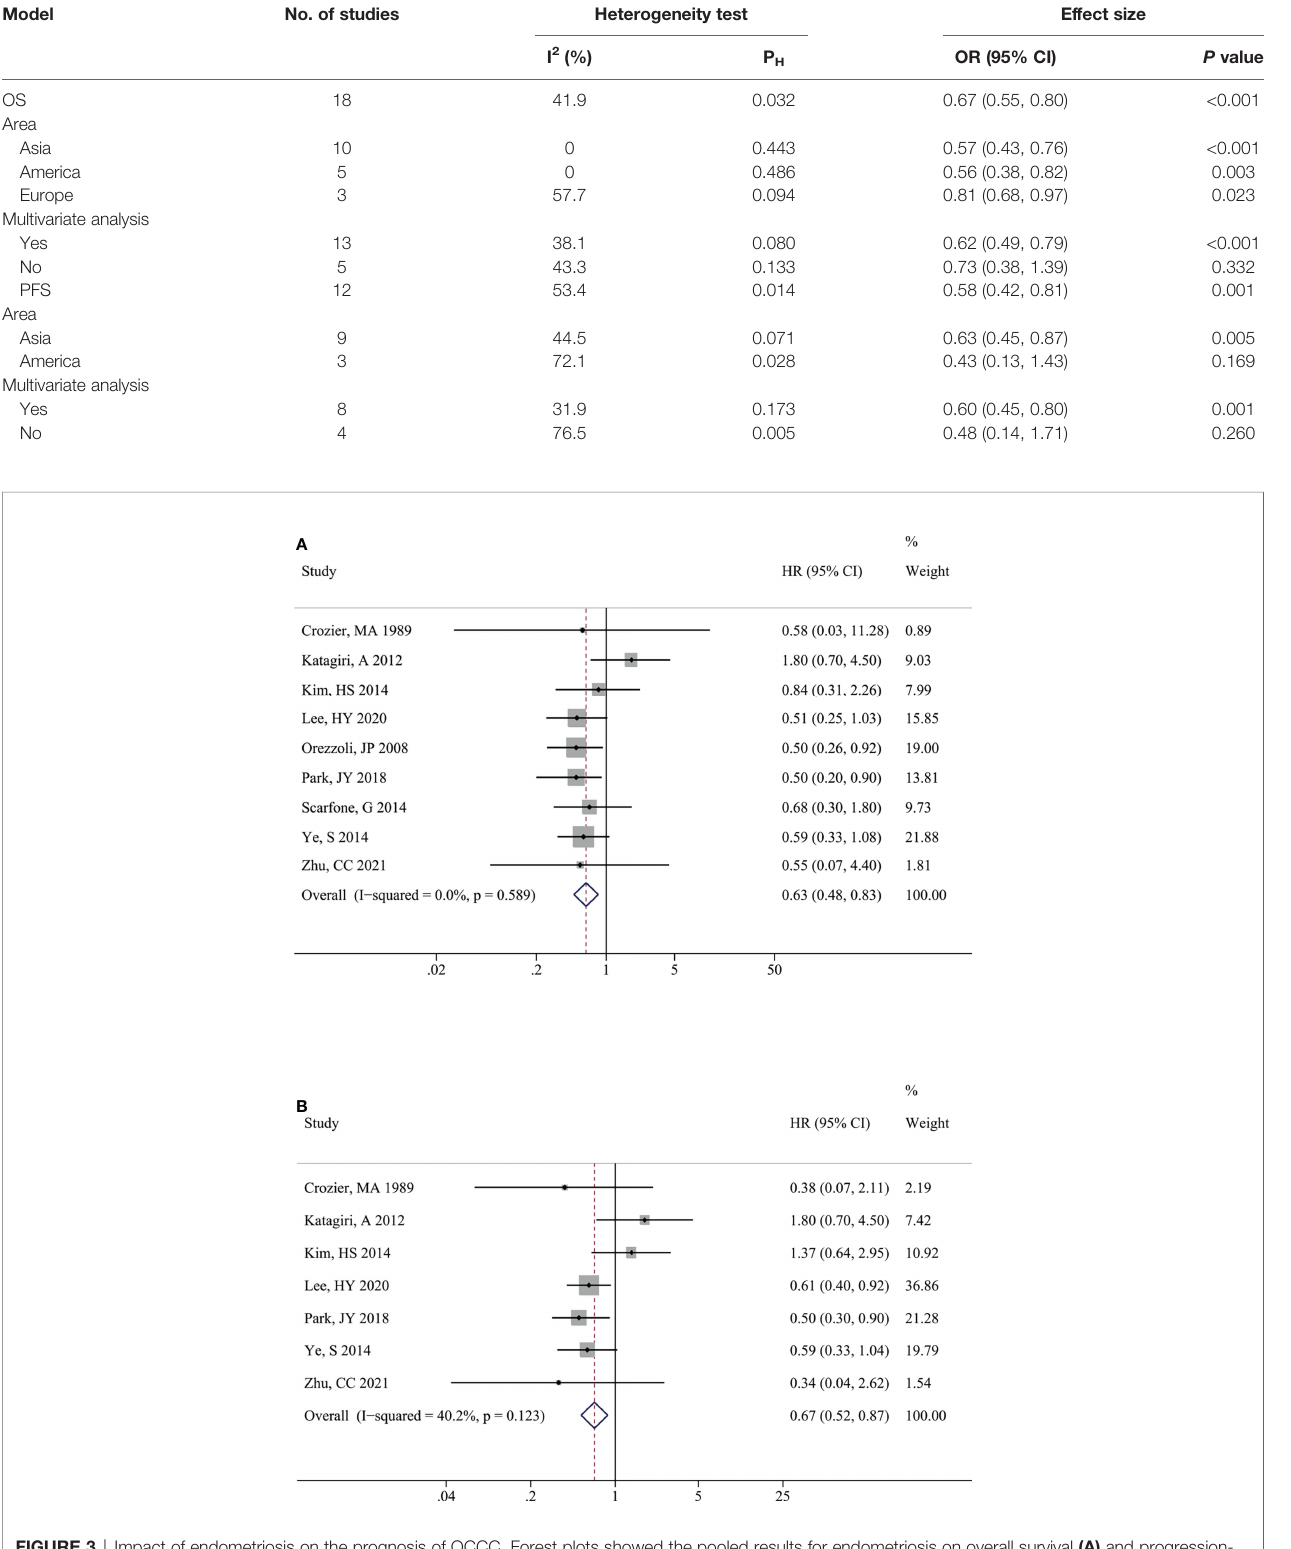
FIGURE 3 | Impact of endometriosis on the prognosis of OCCC. Forest plots showed the pooled results for endometriosis on overall survival (A) and progression- free survival (B) of OCCC patients. OCCC, ovarian clear cell